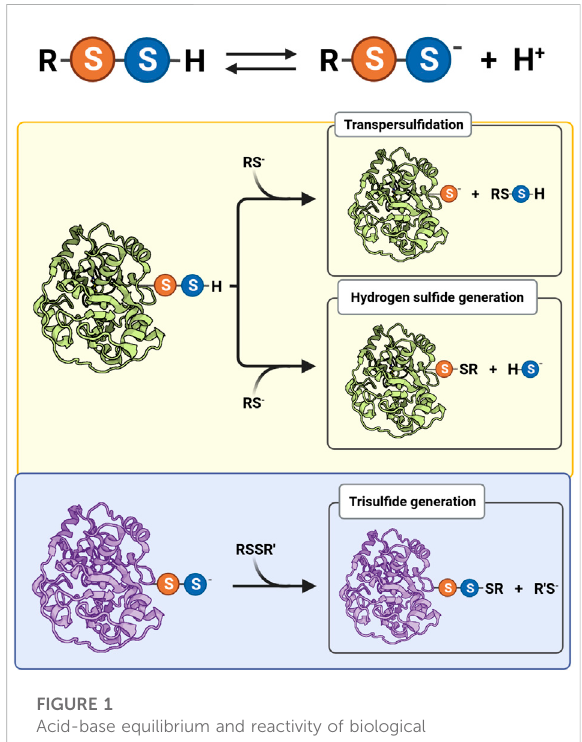
FIGURE 1 Acid-base equilibrium and reactivity of biological hydropersul fi des.Protonated(RSSH)andionizedpersul fi des(RSS − ) are in equilibrium, affecting their reactivity. The electrophilic behavior of protonated persul fi des (yellow background) is exempli fi ed by a protein persul fi de and a thiolate (RS − ) as nucleophile. The nucleophilic behavior of persul fi des (light blue background) is illustrated by a protein persul fi de and a generic disul fi de (RSSR ′ ) as